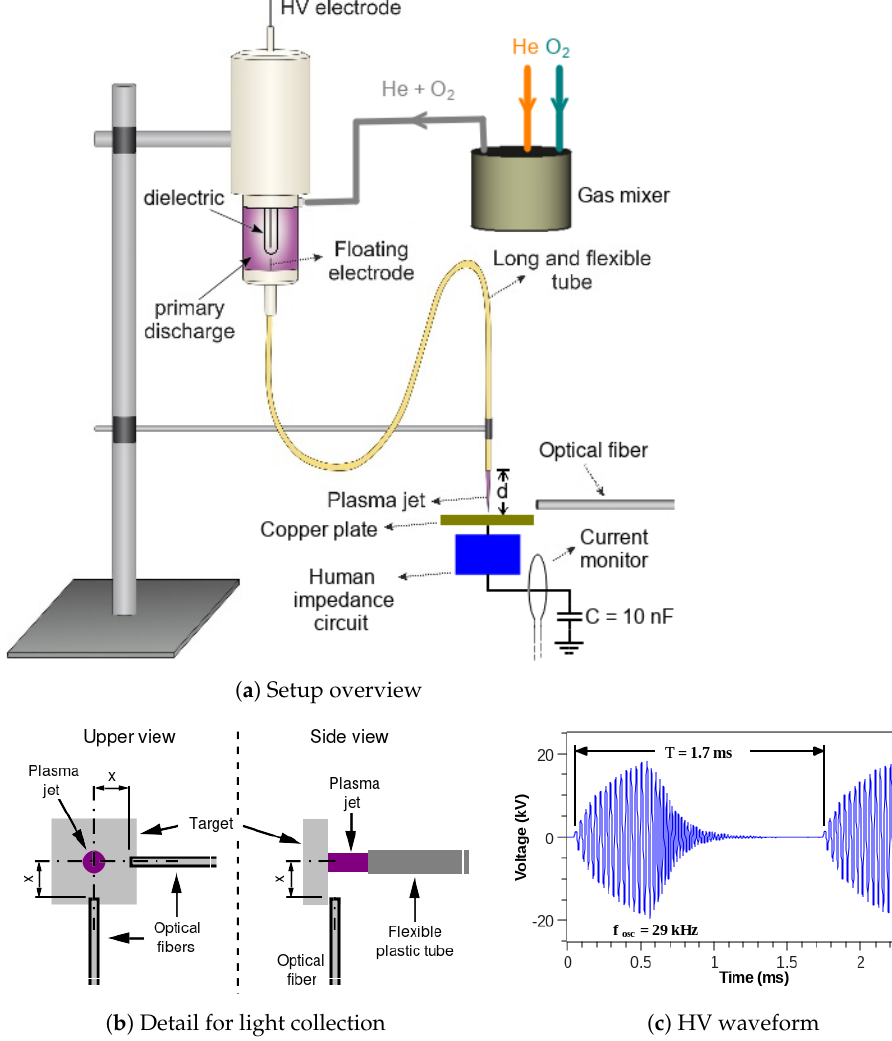
Figure 1. ( a ) Schematic of the experimental setup. ( b ) Details of the arrangement for the optical fibers. ( c ) Example of a typical HV waveform applied to the pin electrode without producing